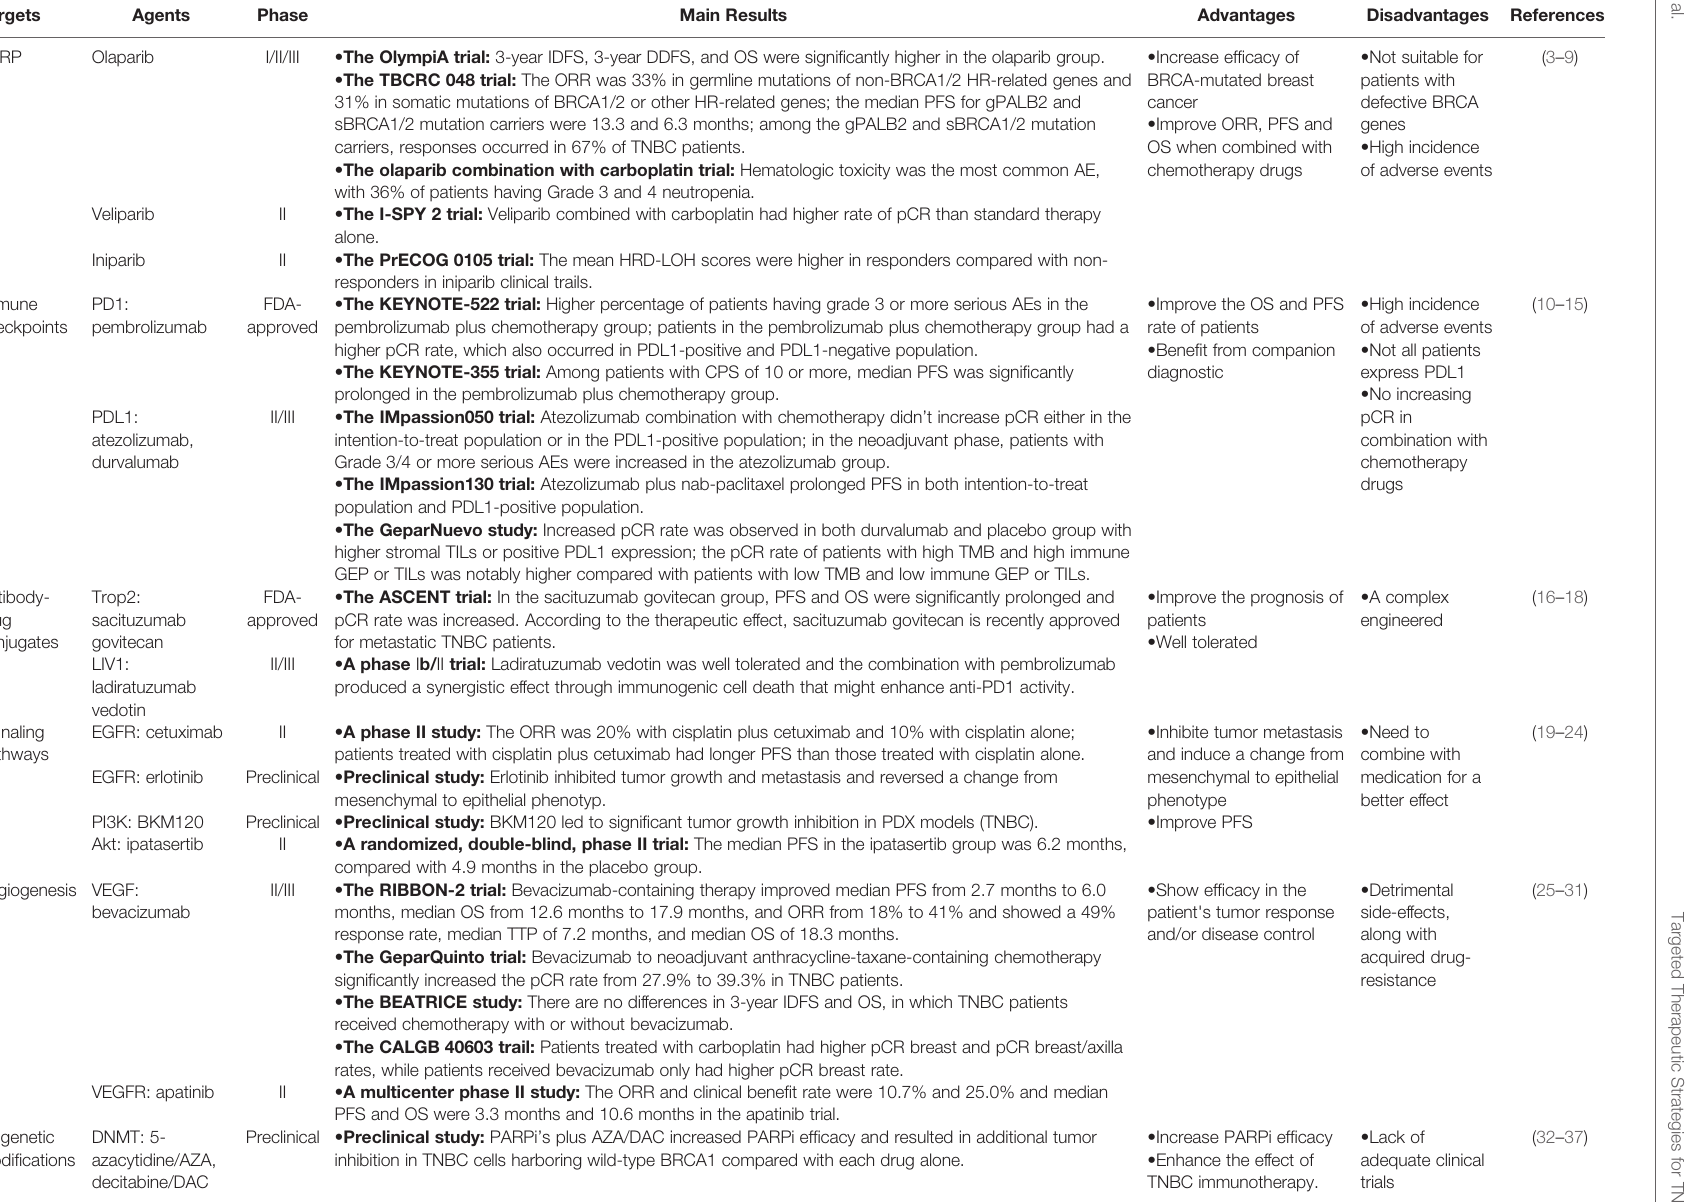
TABLE 1 | Overview of Potential Targeted Therapeutic Strategies for